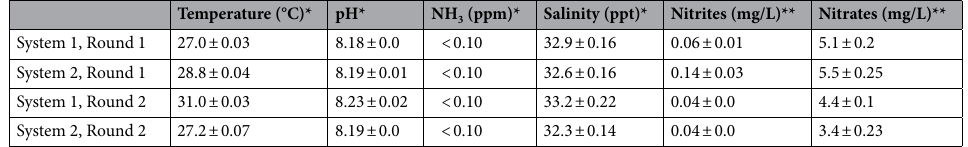
Table 1. The mean (± standard error) water quality parameters measured daily (*) and weekly (**) throughout the